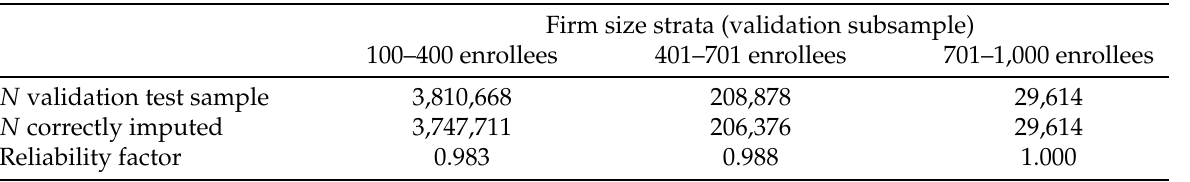
Table A: Validation analysis of employer plan offering deductible type